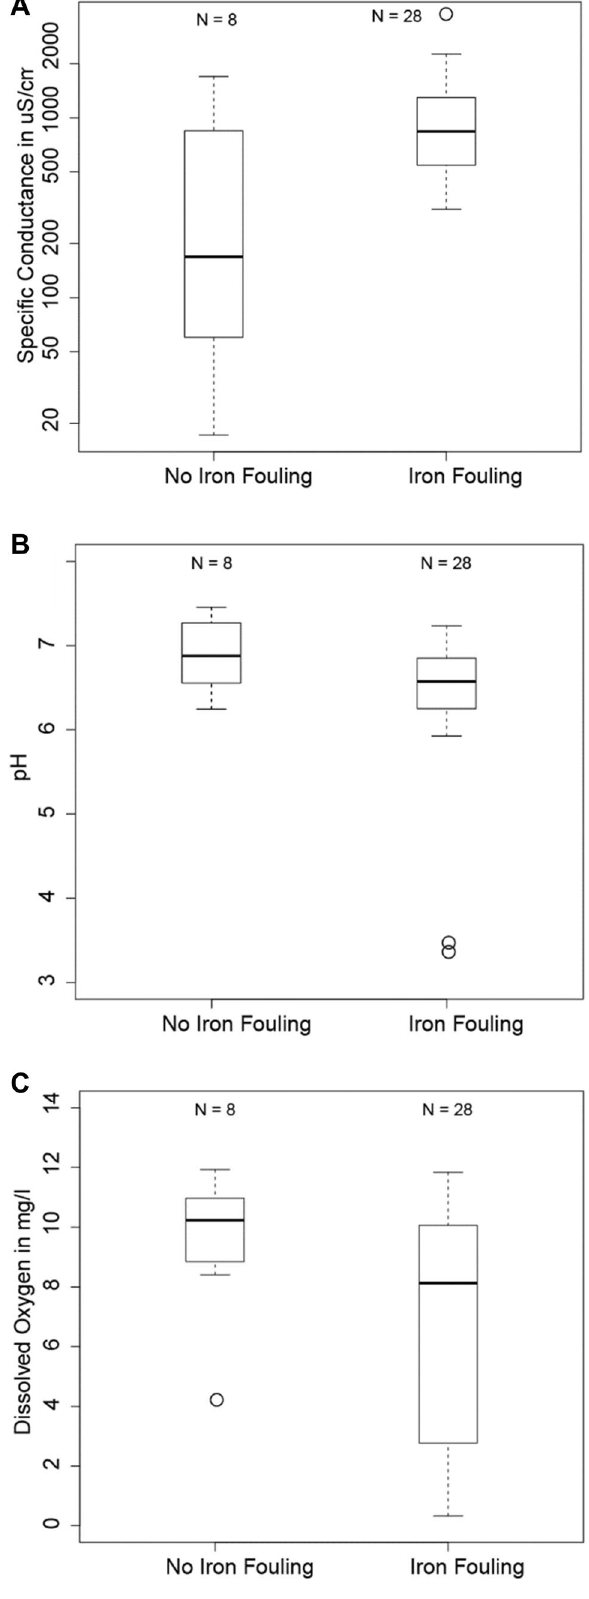
Fig. 2 Tukey box plots showing levels of a SC b pH, and c DO at 28 rock-fill sites with observed iron fouling versus 8 rock-fill sites with no observed iron